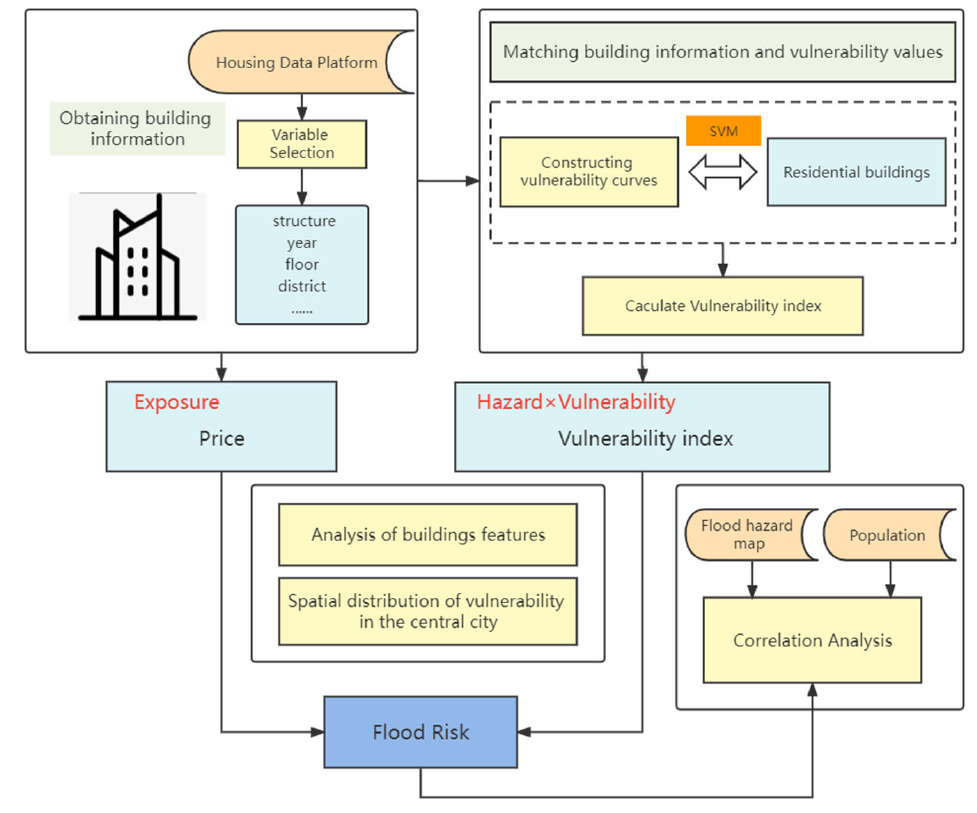
Figure 3. The research framework of flood vulnerability using housing trading platform big data.